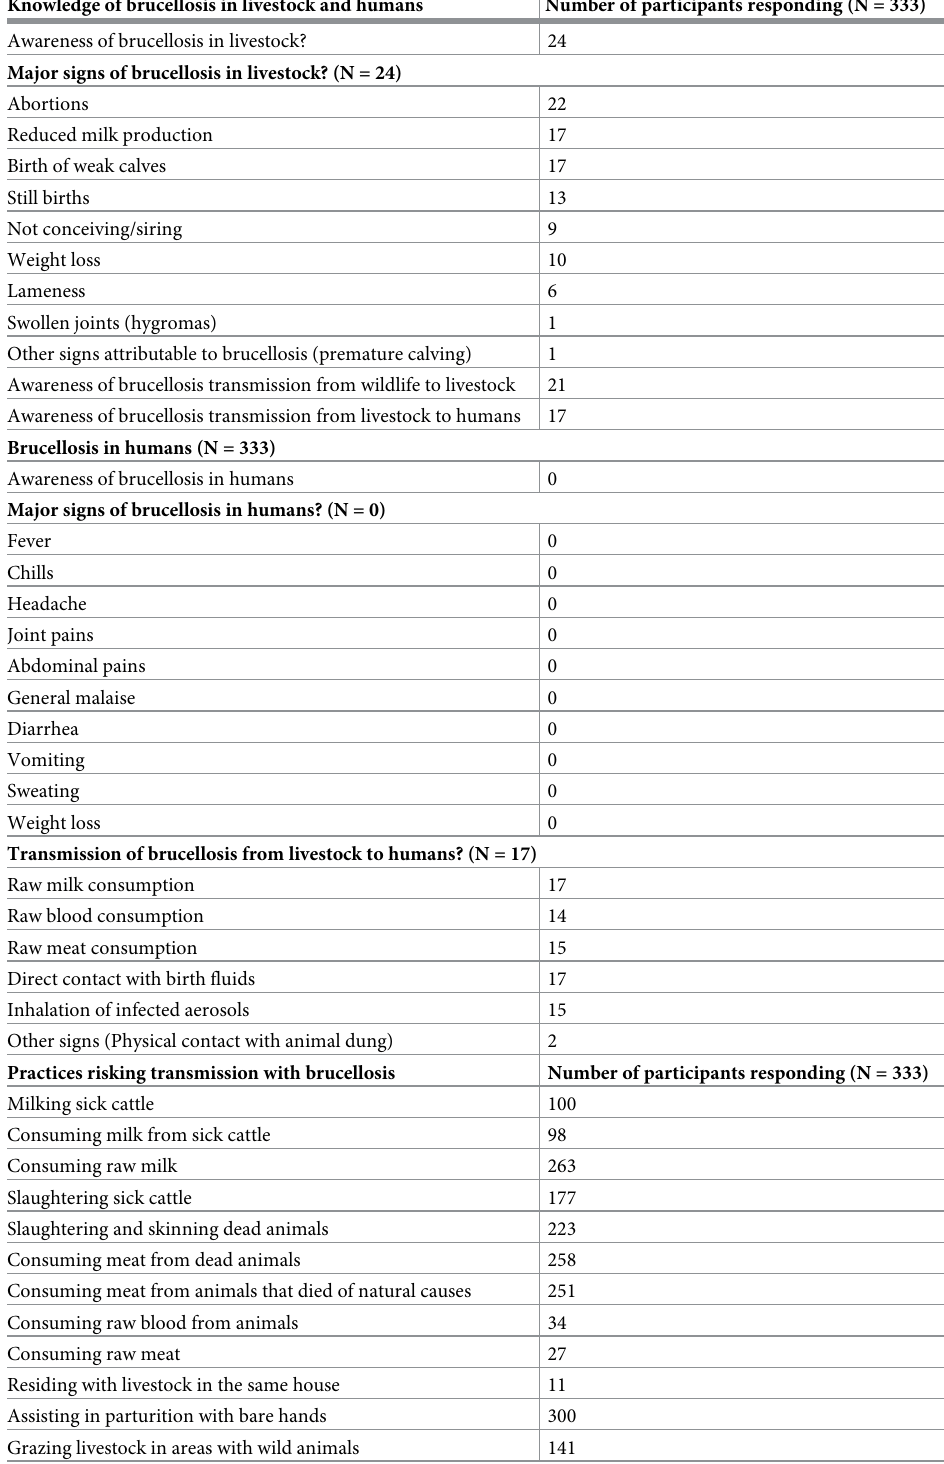
Table 2. Quantitative variables used to score knowledge and practices among the respondents. Knowledge of brucellosis in livestock and humans Number of participants responding (N = 333) Awareness of brucellosis in livestock? 24 Major signs of brucellosis in livestock? (N = 24) Abortions 22 Reduced milk production 17 Birth of weak calves 17 Still births 13 Not conceiving/siring 9 Weight loss 10 Lameness 6 Swollen joints (hygromas) 1 Other signs attributable to brucellosis (premature calving) 1 Awareness of brucellosis transmission from wildlife to livestock 21 Awareness of brucellosis transmission from livestock to humans 17 Brucellosis in humans (N = 333) Awareness of brucellosis in humans 0 Major signs of brucellosis in humans? (N = 0) Fever 0 Chills 0 Headache 0 Abdominal pains General